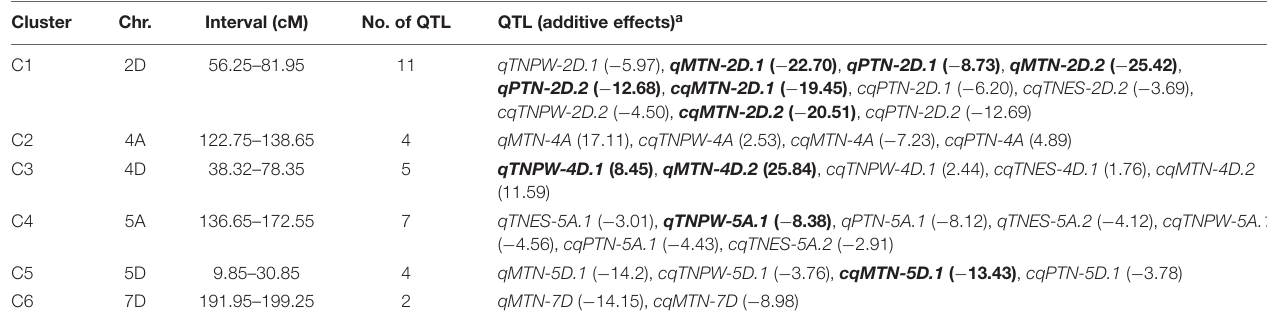
TABLE 5 | QTL clusters simultaneously affecting TNES, TNPW, MTN, and PTN in CN18/T1208 RIL population. Cluster